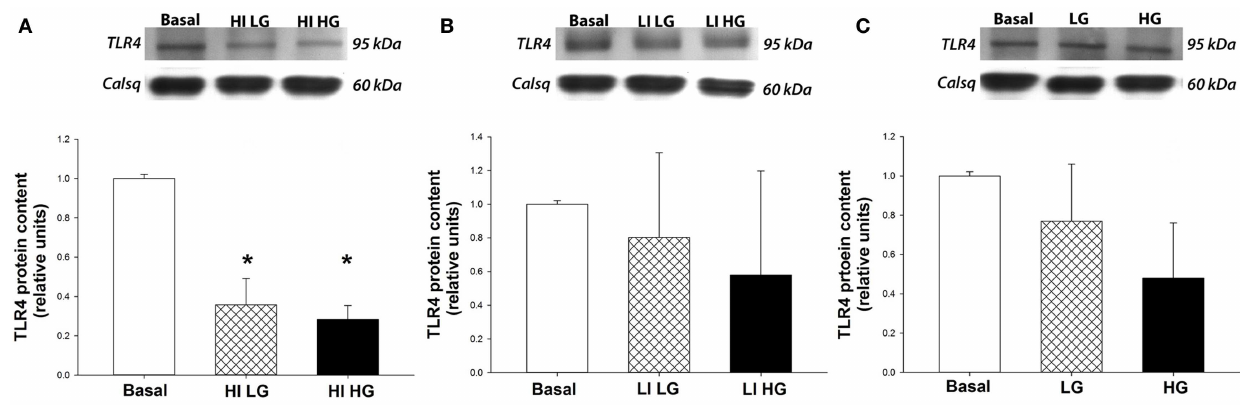
FIGURE 1 | High concentrations of insulin decreaseTLR4 protein expression in isolated cardiac myocytes .Top panels: representative Western blot ofTLR4 protein expression from total lysates, with calsequestrin as a loading control. Bottom panels: mean ± SE ofTLR4 protein expression ( n = 5/group). * p < 0.05 vs. basal conditions. (A) Cardiac myocytes isolated from healthy rats show a decrease inTLR4 protein expression after incubation with insulin at high concentrations (HI, 500 µ IU/mL) in both physiological